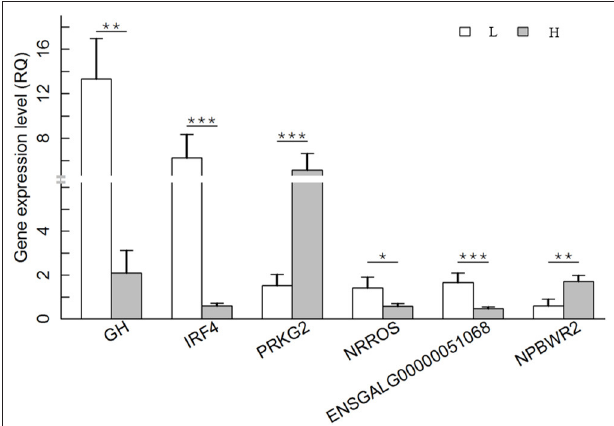
FIGURE 5 | Differential expression levels of the following DEGs between H and L groups was confirmed by qRT–PCR. The x-axis indicates the DEGs, and the y-axis shows the relative quantity (RQ) value. The P value of each pair of comparison is presented in the figure. * P < 0.05; ** P < 0.01; *** P < 0.001. H group: gray bars; L group: white